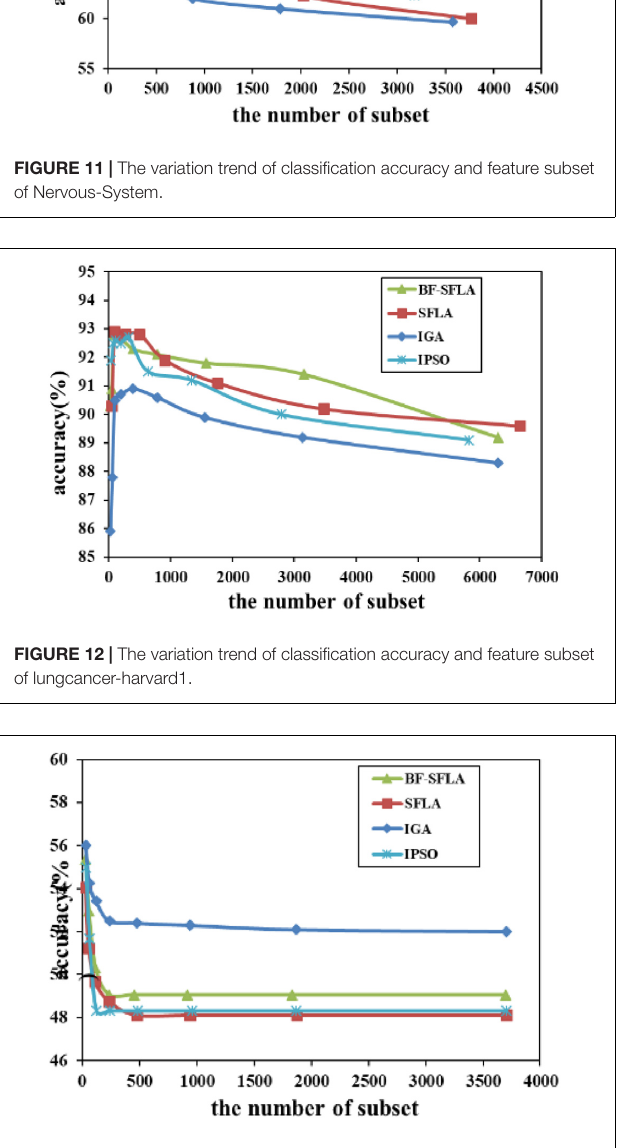
there was no apparent advantage in the early-to-middle stages, the BF-SFLA algorithm could identify fewer feature subsets with higher classification effects and better performance